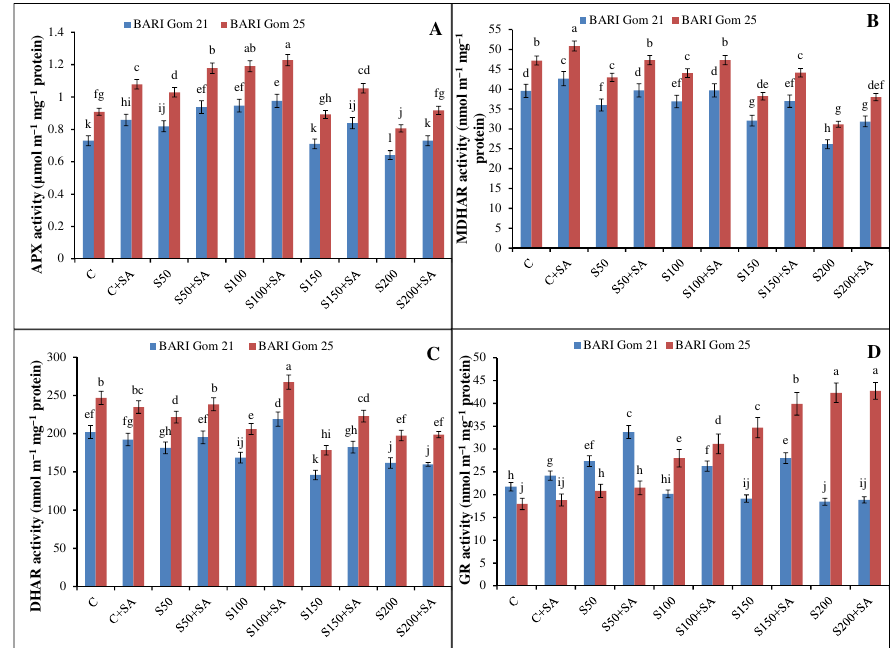
Fig. 4. ( A ) APX activity, ( B ) MDHAR activity, ( C ) DHAR activity and ( D ) GR activity in salt sensitive and salt tolerant wheat plants induced by exogenous salicylic acid under salt stress. S50, S100, S150 and S200 indicate 50 mM, 100 mM, 150 mM NaCl and 200 mM NaCl, respectively. In Y-axis, m -1 indicates ‘per minute’. SA indicates 1 mM salicylic acid spray, respectively. Mean (±SD) was calculated from three replicates for each treatment. Values in a column with different letters are significantly different at p ≤ 0.05 applying LSD